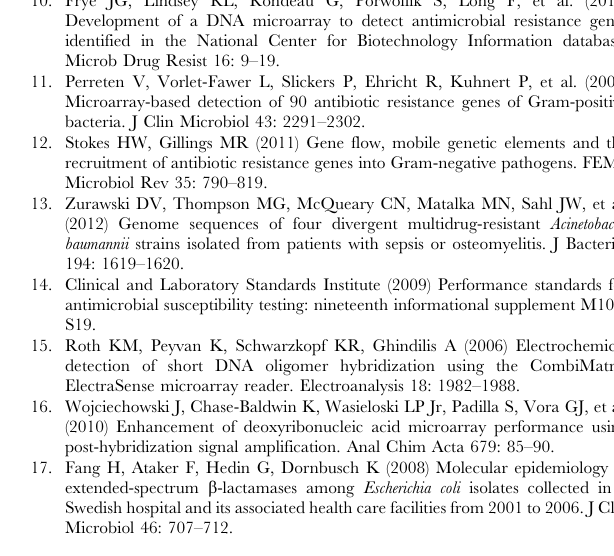
Table S1 Antibiotic resistance profiles of the clinical isolates 1 . 1 R - resistant, S - sensitive, I - intermediate resistant (according to CLSI criteria). Blank cells - test was not